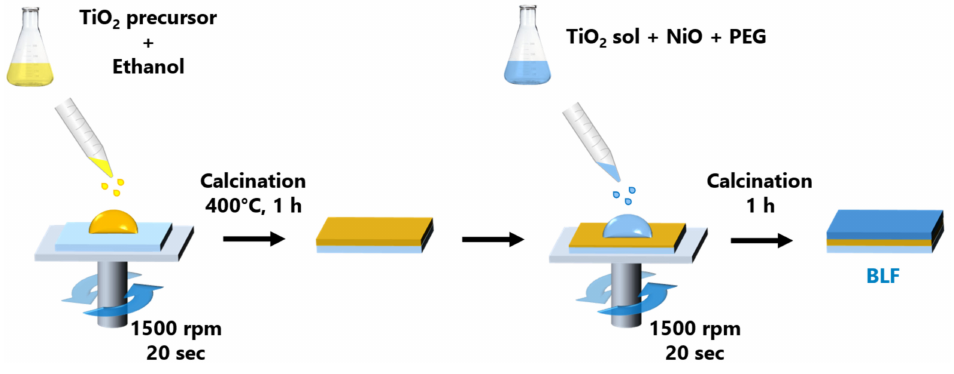
Figure 1. Schematic of BLF